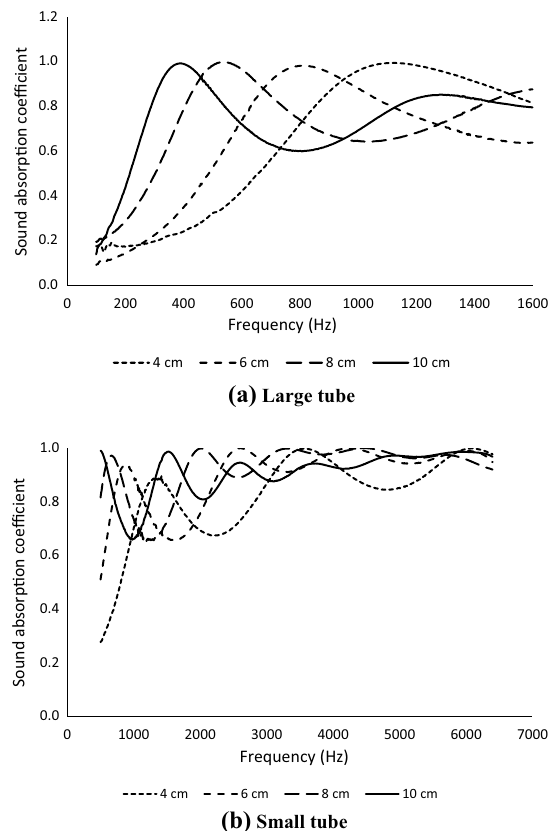
Fig. 4 Sound absorption curves of pine cone particle sound absorbers depending on thickness